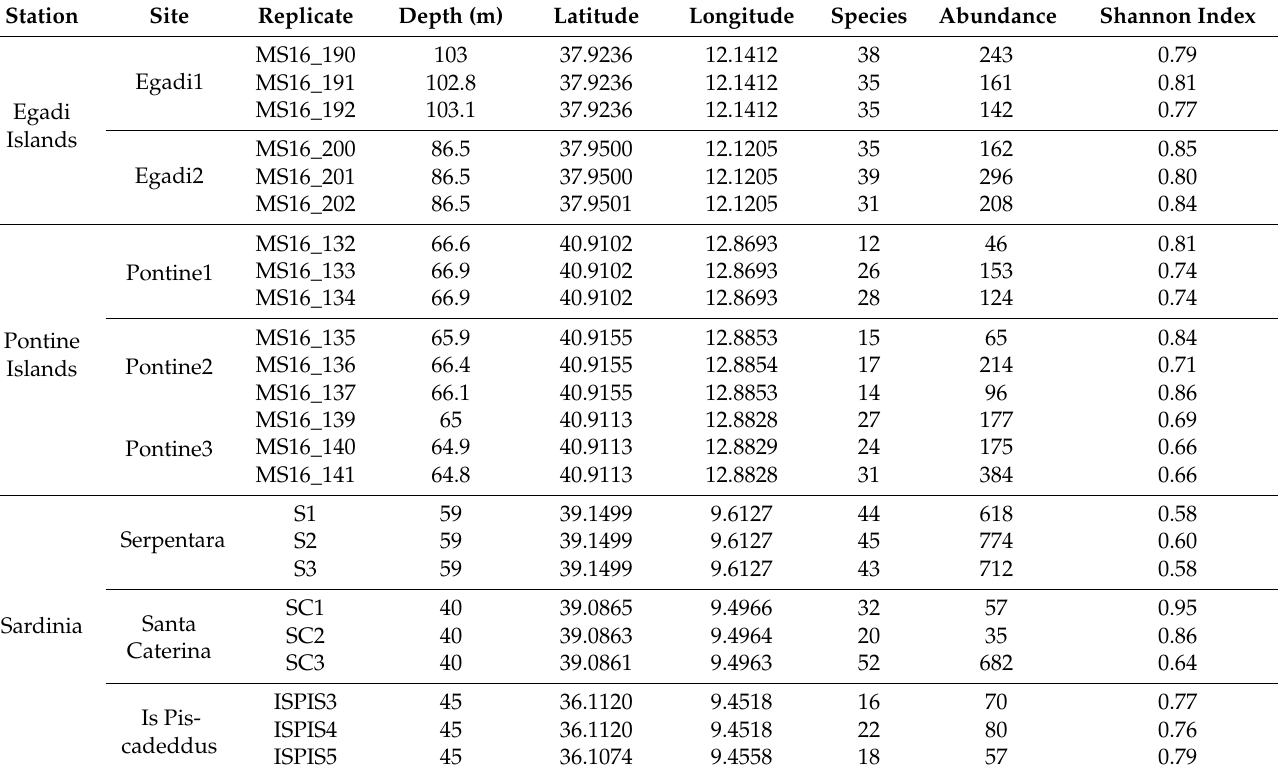
Table 1. List of stations, sites, and replicates with the indication of depth, location, number of identified species, specimens abundance, and Shannon Diversity